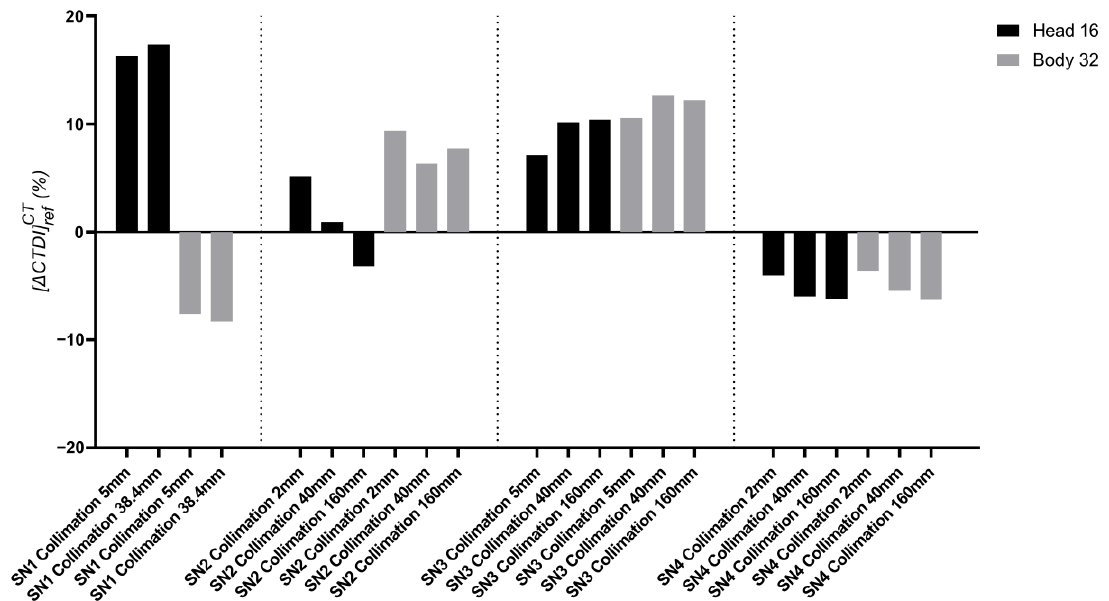
Figure 5. Relative deviation between 𝐶𝑇𝐷𝐼 𝑤 displayed by the CT scan and CT chamber, [∆𝐶𝑇𝐷𝐼] 𝑟𝑒𝑓𝐶𝑇 , for standard 120 kV radiation dose quality control (RDQC) performed on a Siemens SOMATOM® definition AS+ (SN1), a Canon Medical Aquilion ONE Genesis (SN2), a GE Healthcare Revolution CT (SN3) and a Canon Medical Aquilion ONE/PRISM Edition (SN4). The measurements were performed at the minimum, maximum and most used beam widths for head and body proto- cols.